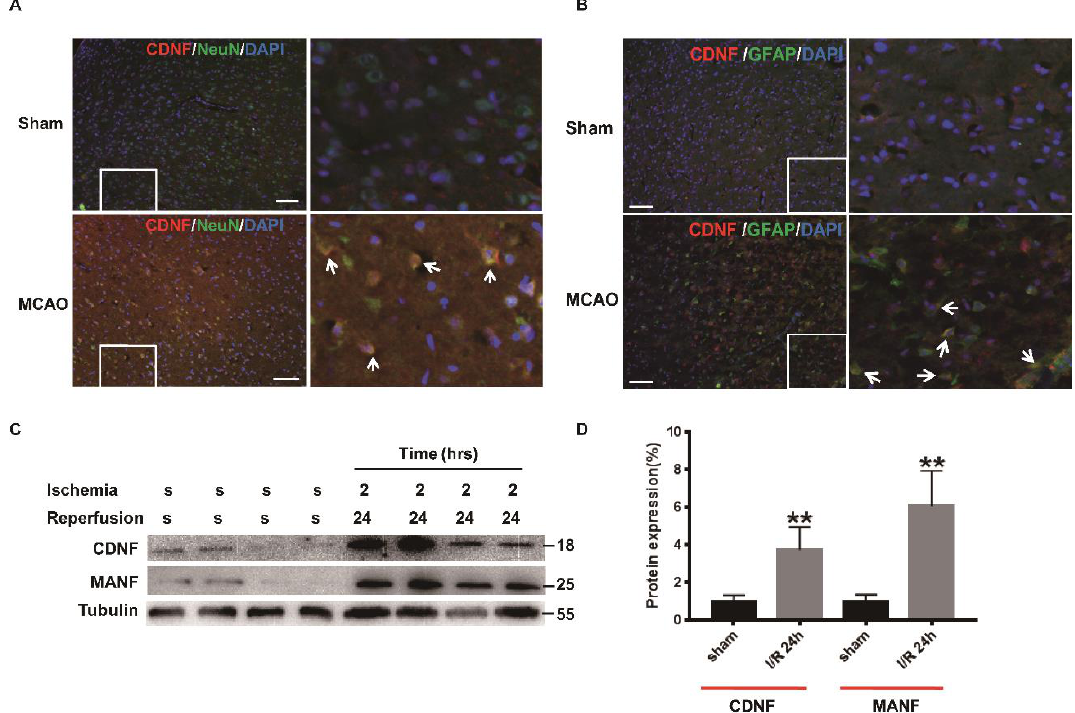
Figure 4. The expression of CDNF in the ischemic cerebral cortex. ( A ) CDNF (red)/NeuN (green) double labeling in the ipsilateral cortexes. DAPI (blue) labeled all the nuclei. Scale bar = 45 μm. The insets show photomicrographs of the cortex at higher magnification. Arrows point to the CDNF + /NeuN + cells. ( B ) CDNF (red)/GFAP (green) double labeling in the ipsilateral cortexes. DAPI (blue) labeled all the nuclei. Scale bar = 45 μm. The insets show photomicrographs of the cortex at higher magnification. Arrows point to the CDNF + /GFAP + cells. ( C ) The representative Western blotting to show the expression of CDNF. The samples of the ischemic penumbra were collected at I/R 24 h. Tubulin was used as a loading control. S, sham; MANF as the positive control. ( D ) Protein levels were quantified as relative levels compared to Tubulin, three independent experiments were performed and the reported data represent the mean of the three experiments, Student’s t -test, ** p <